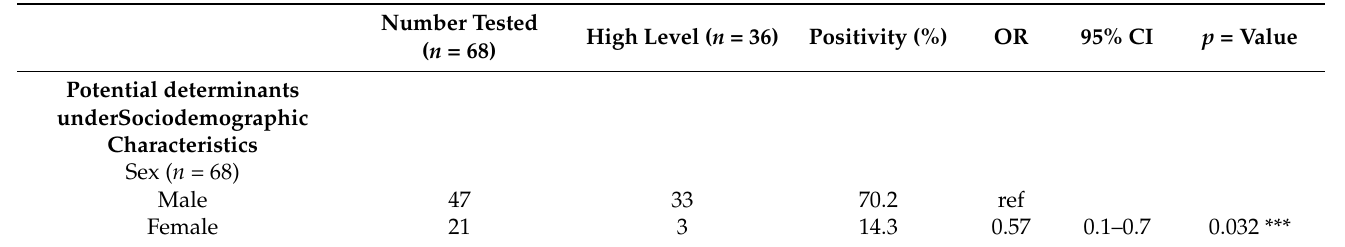
Table 7. Summary of bivariate analysis between potential determinants of knowledge, attitude, and practices toward